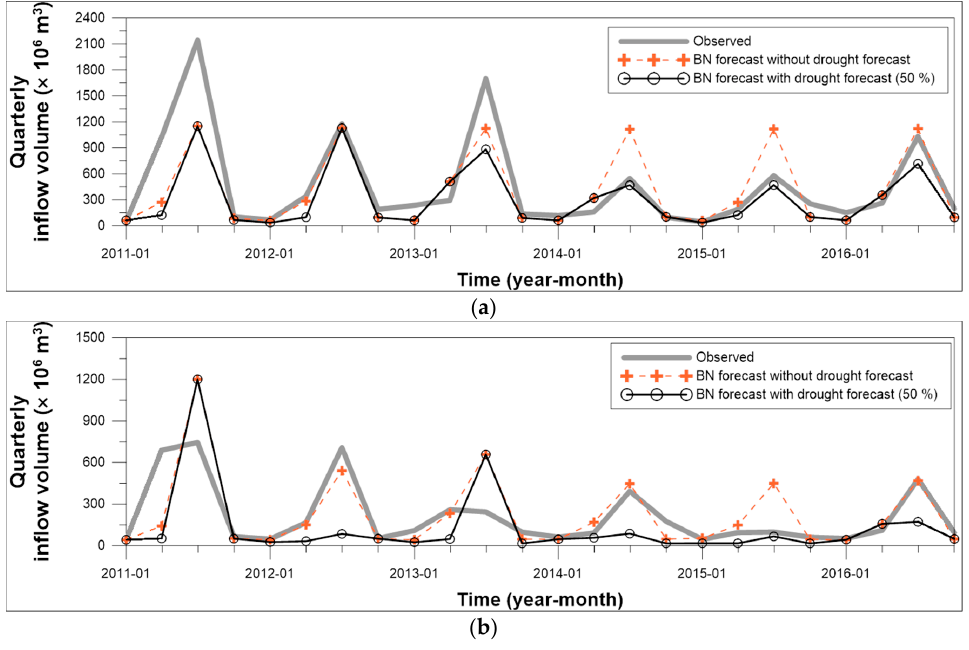
Figure 13 . The results of quarterly inflow forecasting without or with drought forecast under the threshold probability of drought occurrence to 50%: ( a ) Soyanggang dam; ( b ) Andong dam.